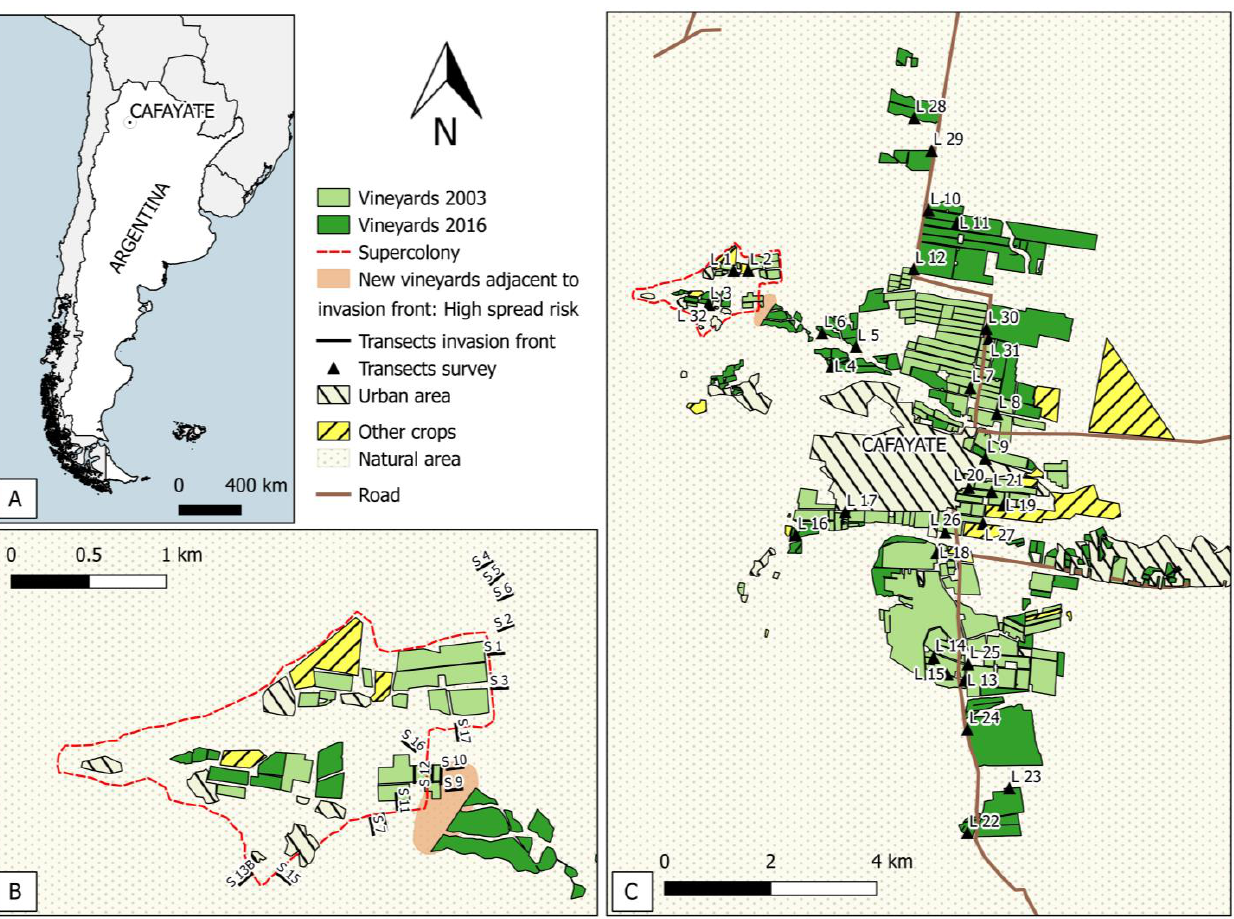
Figure 1. ( A ) Location of Cafayate; ( B ) Limits of the area invaded by L. humile (red dashed line, Paris 2011) and sampling transects (S1 to S17) in the invasion front; area with high risk of colony advance is marked in light red; ( C ) Evolution of vineyard land between 2003 (light green) and 2016 (dark green), and location of sampling transects (L1 to L32) for early detection of L. humile in other locations within the Cafayate area. Urban areas (grey, hatched), other crops (yellow, hatched), and natural area (grey dots) are displayed as well.